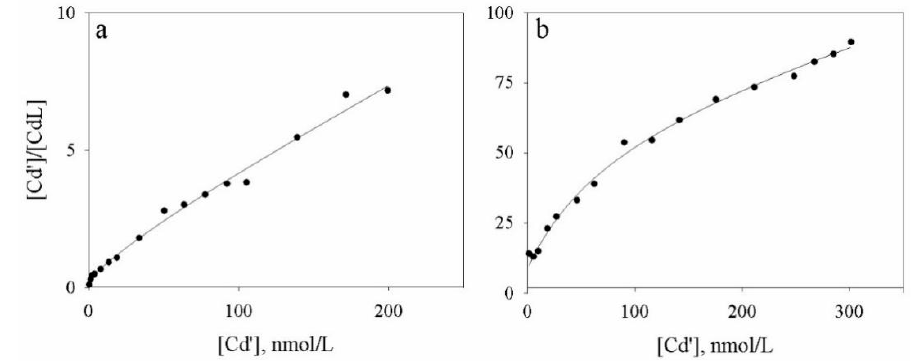
Figure 4. Plot of the elaborated data obtained from the ASV titration ( a ) and obtained from HPSEC- HPSEC-ICP-MS titration ( b ) for ICP-MS titration ( b ) for Cd.